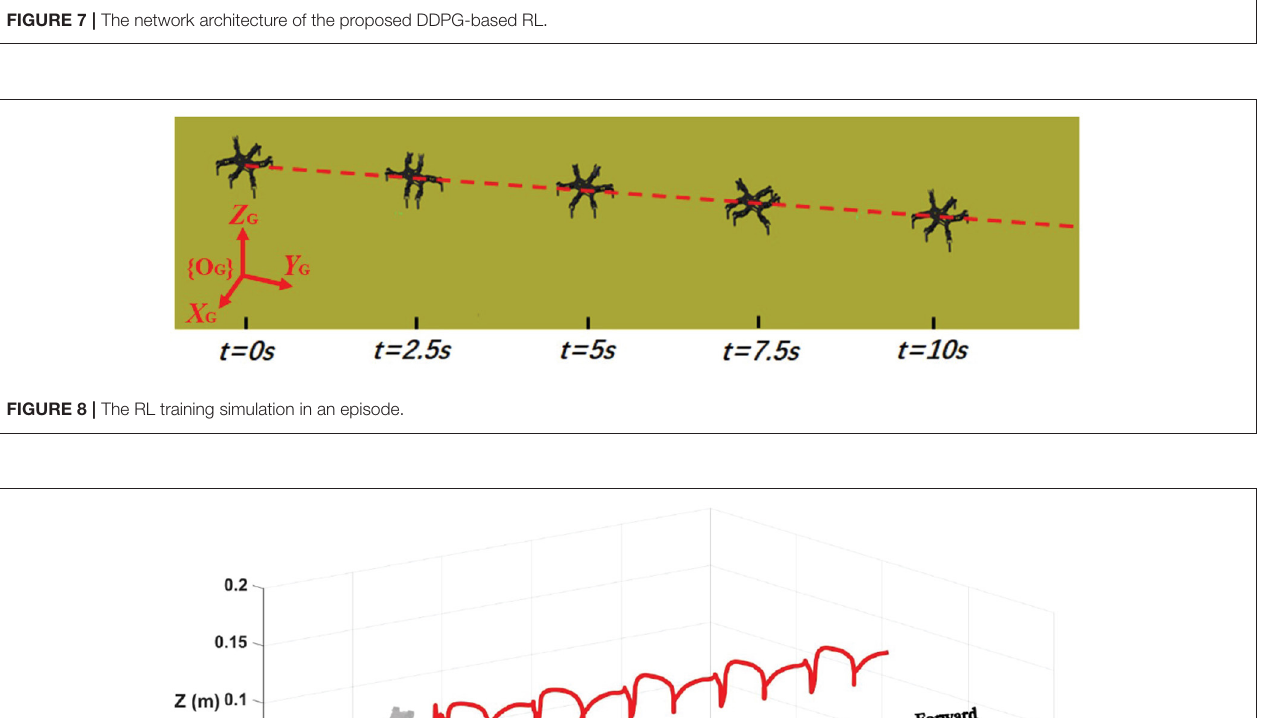
Frontiers in Neurorobotics |